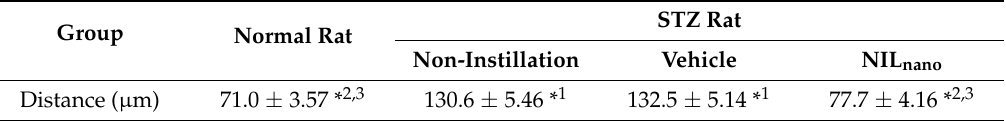
One percent NIL was instilled for two weeks (twice a day, 9:00 a.m. and 7:00 p.m.) following the injection of streptozotocin. Normal rat, non-instilled normal rats; Non-instillation, non-instilled STZ rats; Vehicle, vehicle-instilled STZ rats; NIL nano , NIL nano -instilled STZ rats. n = 5. * 1 p < 0.05, vs. normal rat. * 2 p < 0.05, vs. non-instillation. * 3 p < 0.05, vs. vehicle. The instillation of NIL nano prevented the spread of cells in the inner plexiform layer, and the outer and inner nuclear layers (neural layer) of the retinas.